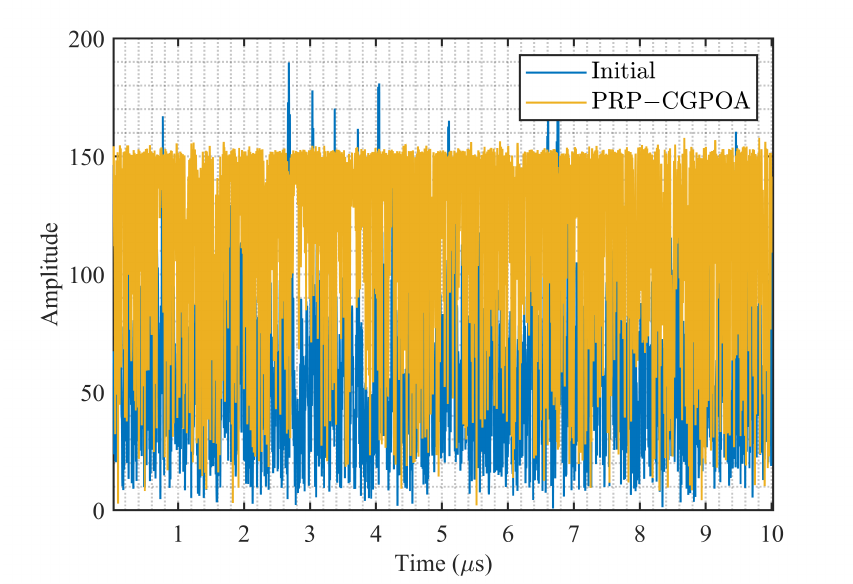
Figure 3. Envelopes of the initial and integrated waveform.